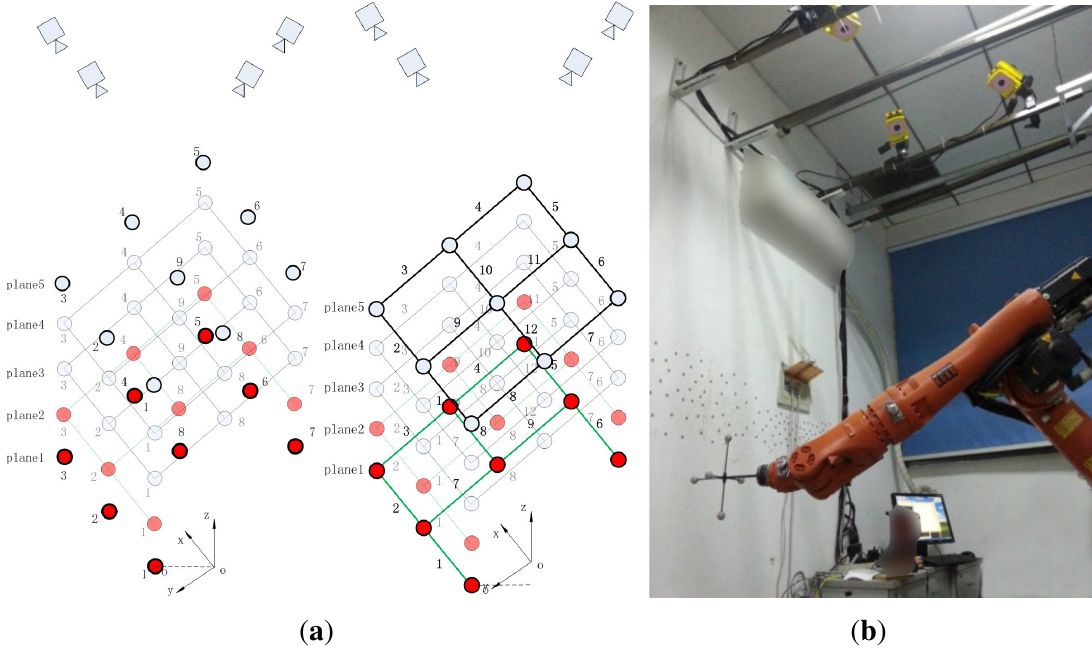
Figure 2. ( a ) Experimental principle of repeatability precision of the photogrammetry system; ( b ) the image of the experimental